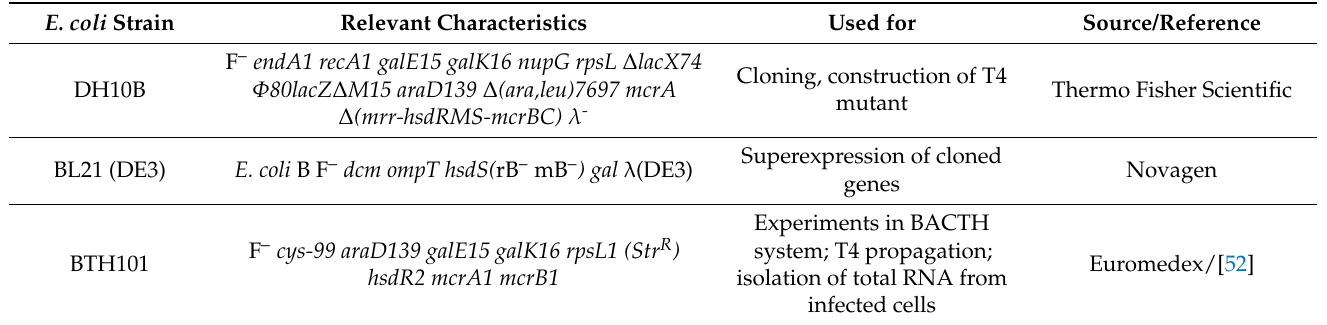
Table 1. Escherichia coli strains, phages, and plasmid vectors used.